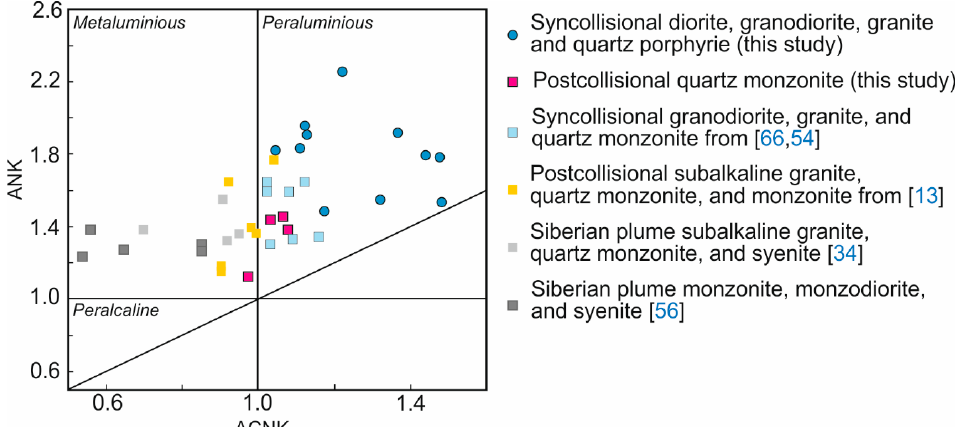
Figure 11. ANK (molar Al 2 O 3 /(Na 2 O + K 2 O)) versus ACNK (molar Al 2 O 3 /(CaO + Na 2 O + K 2 O)) diagram after [99] for the studied felsic rocks.